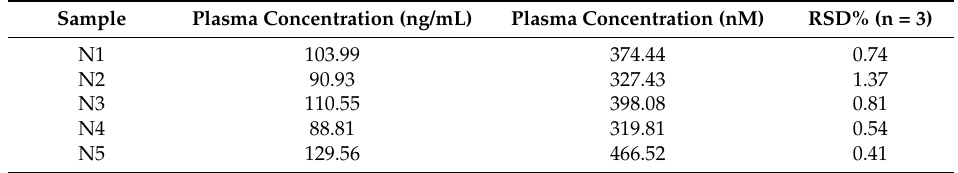
Table 4. PlasmaconcentrationsofNec-1sfoundinrats50minafteri.v. bolusdose(0.37mg/kg)administration.